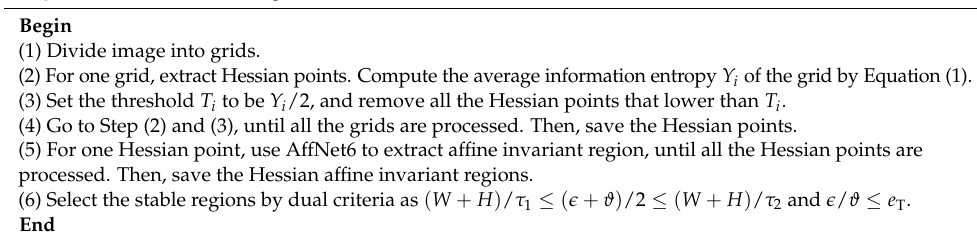
Figure 2. Matching performances of multiple versions of AffNet with different configurations, where AffNet6 provides the best result. Algorithm 1. IHesAffNet Region